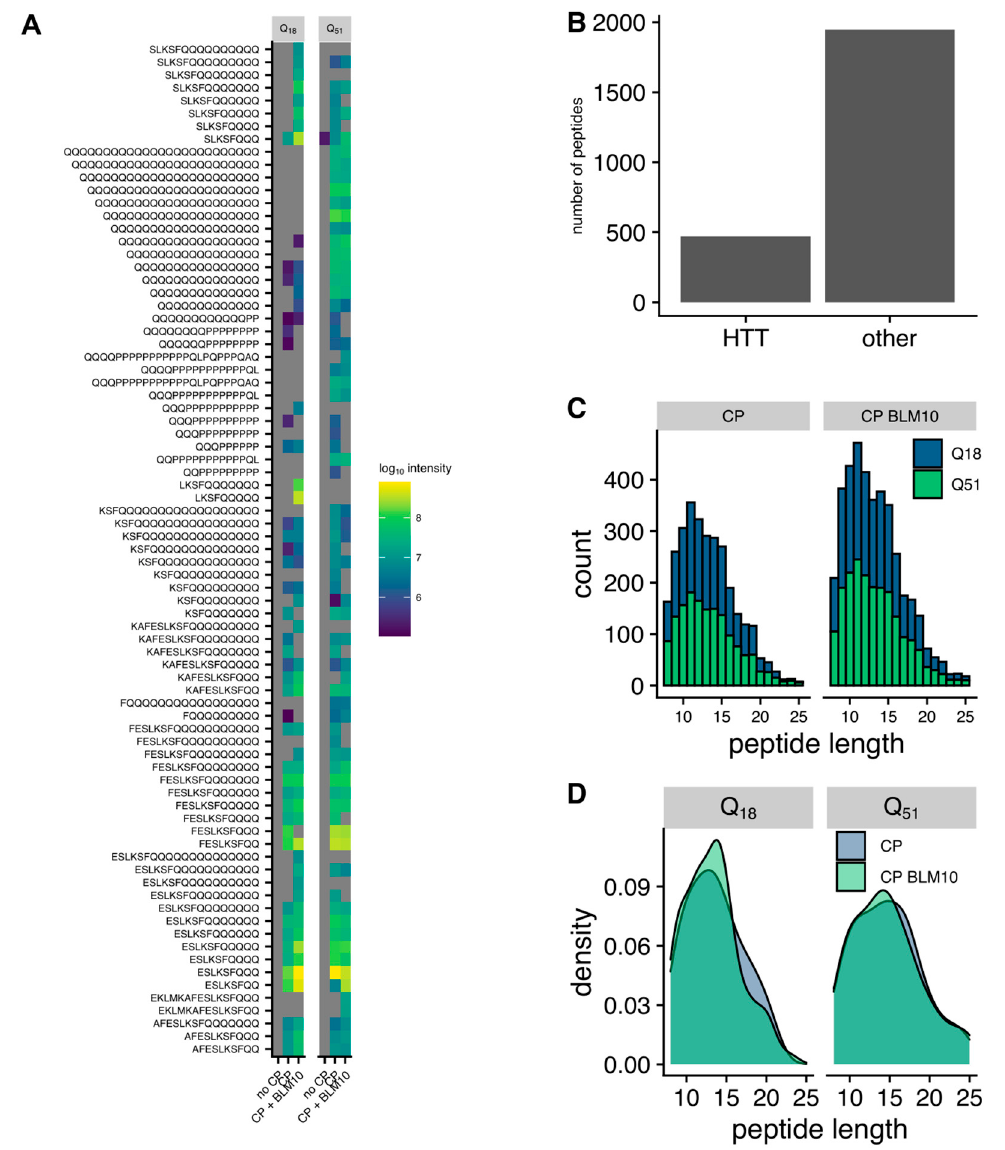
Figure 7. Peptidomics analysis of peptides generate by the CP and Blm10-CP complex. ( A ) Heatmap of the peptides generated in an in vitro degradation experiment of Htt18Q and Htt51Q with either no CP, CP, or the Blm10-CP complex. The color indicates the intensity of the detected peptide, while grey indicates that the peptide was not detected. ( B ) Htt derived peptides account for ≈ 20% of the total number of peptides detected in the in vitro reaction. ( C ) Histogram representing the peptide length distribution in the presence of the CP vs. Blm10-CP. ( D ) Density plot of the peptides generated from the degradation of Htt-18Q and Htt-51Q in the presence of CP vs. Blm10-CP.